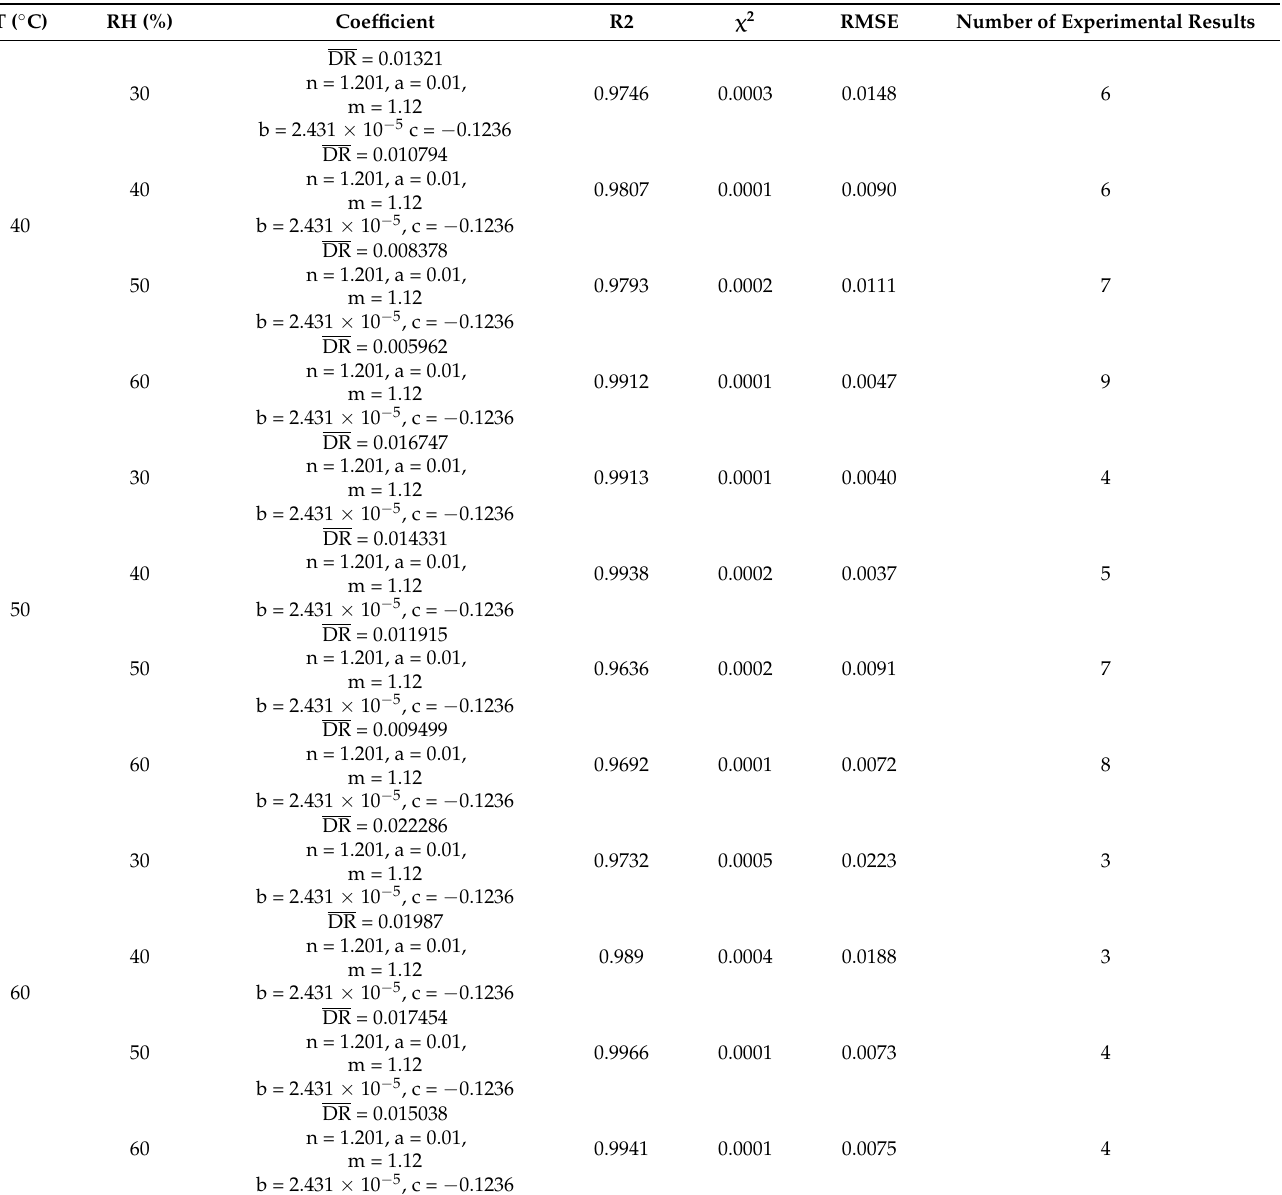
Table 5. Statistical analysis data of the second stage of the new model for sludge